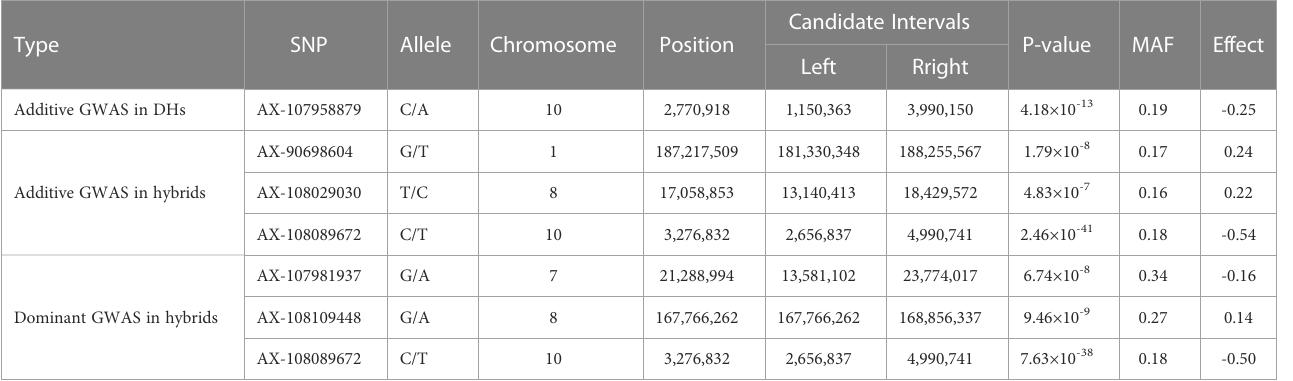
TABLE 3 The results of the genome-wide association (GWAS) analysis.